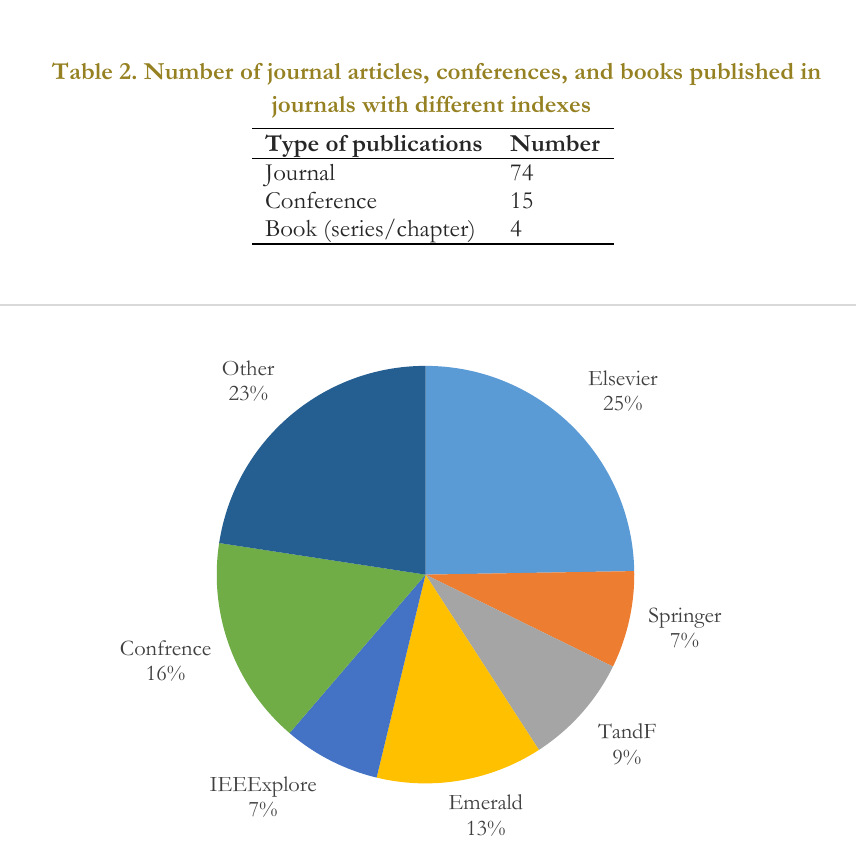
Fig. 4. Number of articles published by different